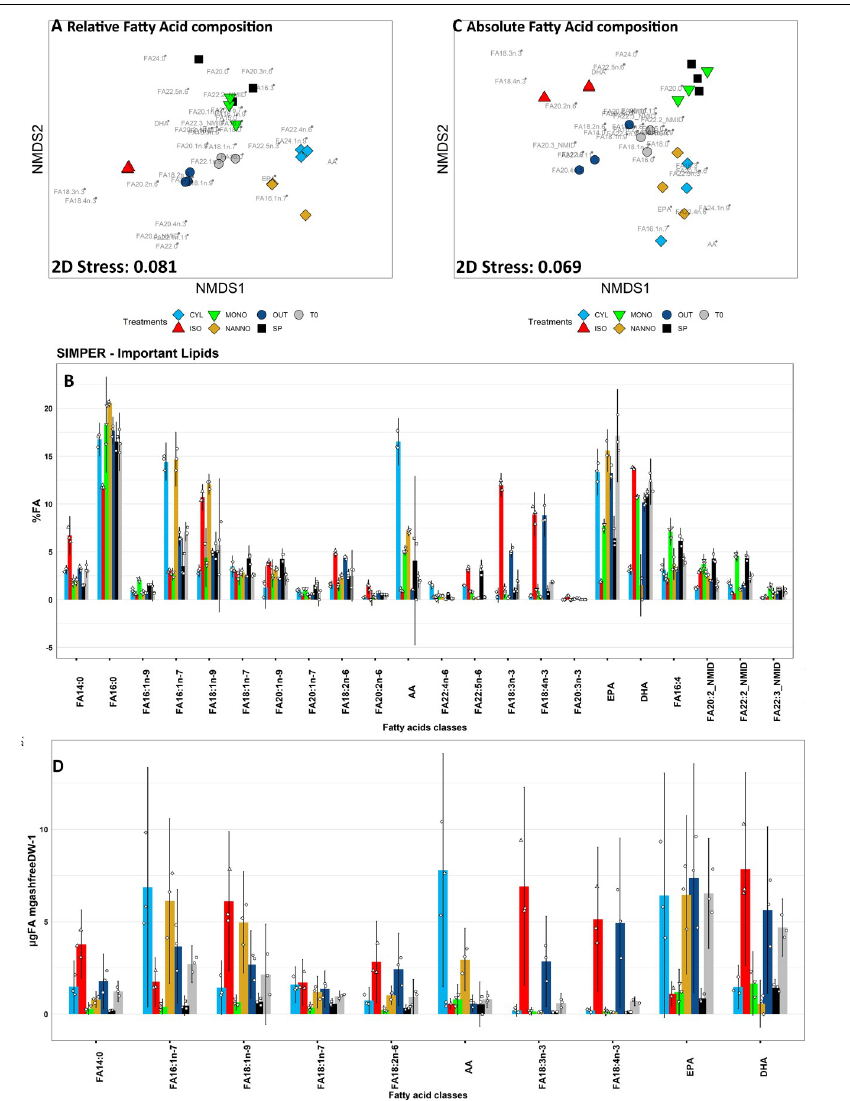
Fig 3. Non metric multidimensional scaling (nMDS) analisis and similarity percentages (SIMPER) analysis for relative (A-B) and absolute (C-D) fatty acid composition of spat subjected to the diet treatments. A: nMDS plot of the relative FAME composition of spat (%FA) subjected to the feeding trial. Single FA loadings are stacked on the plot and reported in grey. B: principal variables explaining for a cumulative 75% of group differences in relative spat FA composition data evidenced by SIMPER analysis. C: nMDS plot of the absolute ( μ gFA mg ashfreeDW-1 ) fatty acid composition of the spat. Single FA loadings are stacked on the plot and reported in grey. D: principal variables explaining for a cumulative 75% of group differences in absolute spat FA composition data evidenced by SIMPER analysis. T0: Spat sampled before the beginning of the trial, SP: spat fed with ShellPaste during the 4 weeks diet trial; CYL: spat fed with C. fusiformis 1017/2 during the 4 weeks diet trial; ISO: spat fed with I. galbana 927/1 during the 4 weeks diet trial; MONO: spat fed with M. subterranean 848/1 during the 4 weeks trial; NANNO: spat fed with N. oceanica 849/10 during the 4 weeks trial; OUT: spat deployed outdoor and sampled after 4 weeks. Three replicates (n = 3) for each sample group are here reported. Charts B-D: data are reported as average (histogram) ± 95% confidence interval; individual observations are jittered on the chart (smaller dots). The complete data for FA analysis of spat and statistical significance is provided in S3 Table. as their absolute content remained stable between T0 and the spat diet groups. Indeed, the absolute content of polar lipids was also hardly affected by the different diets, with only LPC